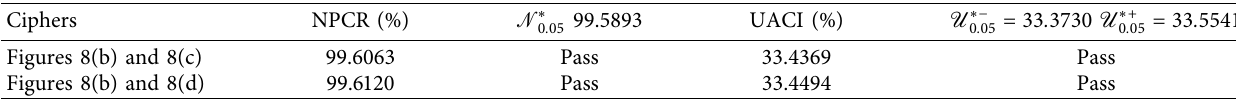
Table 4: Results of NPCR and UACI between ciphers.